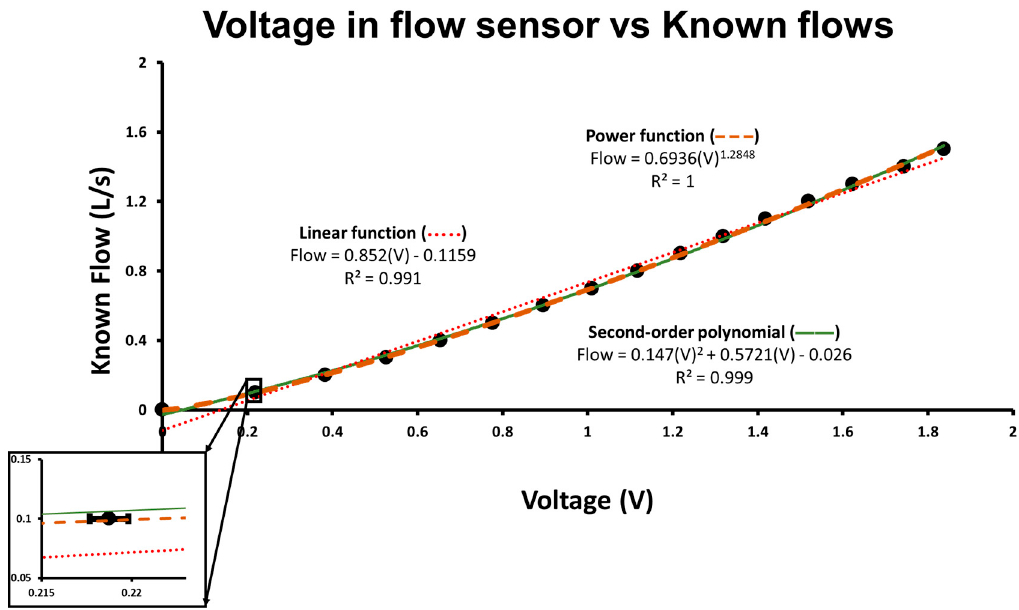
Figure 1. Known flows versus non-calibrated flow sensor (in volts). The graph represents the non-calibrated recordings provided by the flow sensor at different known flows that were generated by a mechanical ventilator (Evita XL). The ventilator was set to volume control with constant flow and connected to the flow sensor. The flow was progressively increased, and we recorded values (in Volts) provided by the non-calibrated flow sensor. Each point in the graph is the average of 15 measurements at each flow step. Error bars represent standard error of mean but are too small to be viewed in the main graph. A subset of the graph is shown in detail (for the second flow point) to allow the visualization of the size of standard error of mean. Regression lines for linear function (dots), power function (traces), and second order polynomial (line) with their respective equations are shown. Compared to the linear function, the power function improves the fitting and accounts for the nonlinear pressure-flow relationship.